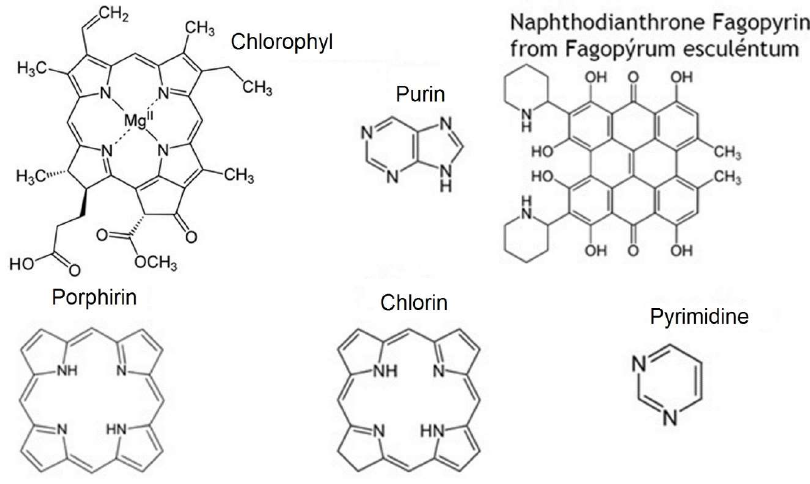
Figure 3. Nitrogen-containing heterocycle secondary plant metabolites possess photo-sensitising properties. Examples of biologically important secondary plant metabolites (nitrogen-containing heterocycles) with photo-sensitising